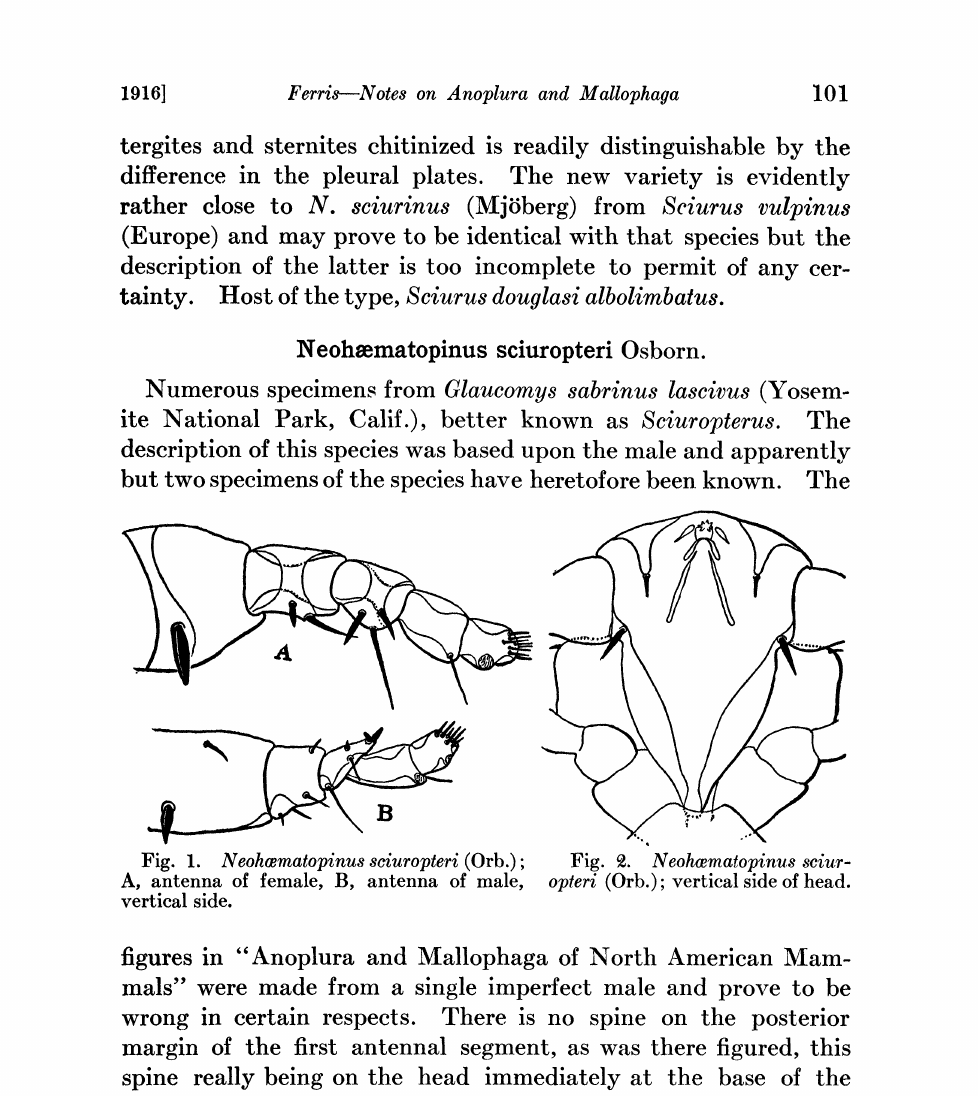
Fig. 1. Neohazmatopinus sciuropteri (Orb.); Fig. 2. A, antenna of female, B, antenna of male, opteri (Orb.); vertical side of head. vertical